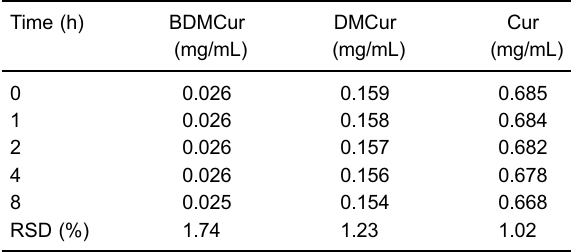
Table 5. Stability investigation results of bisdemethoxycurcumin (BDMCur), demethoxycurcumin (DMCur) and curcumin (Cur) in blank intestinal perfusion fl uid.